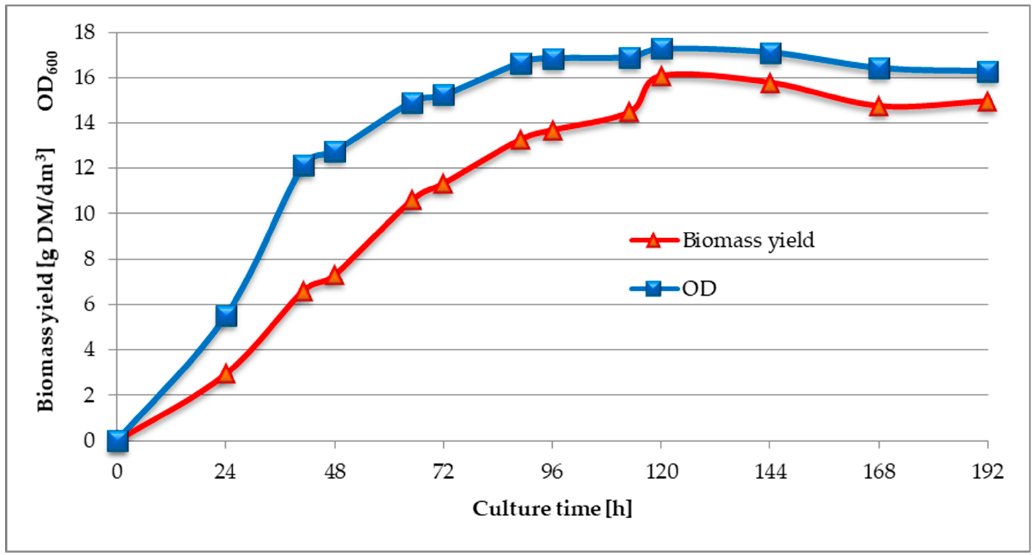
Figure 3. Changes in biomass yield and optical density (OD 600 ) during 192-h culture of C. cylindracea DSM 2031 in a medium with waste fish oil.